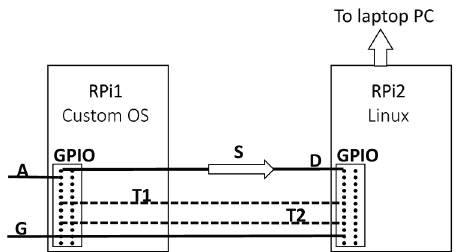
Figure A1. Wiring diagram schematic showing the GPIO wiring connections for the two Raspberry Pi devices. Channel A: data signal (from APD); Channel G: ground signal (from APD); Channel D: data signal; Channel T1: Rpi1 send/receive; Channel T2: Rpi2 send/receive; S: signal to be transferred.